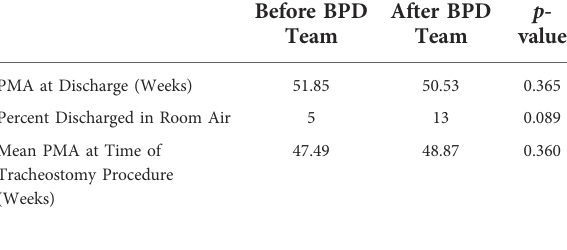
TABLE 3 Characteristics of patients at